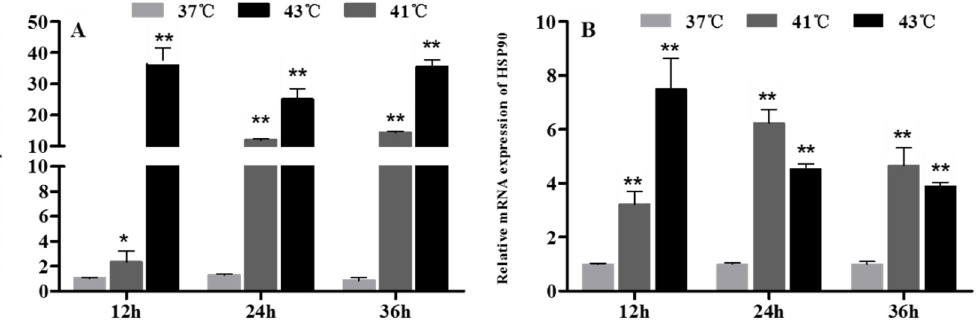
Figure 5. The effect of heat treatment on HSP70 ( A ) and HSP90 ( B ) mRNA expression levels in chicken granulosa cells. * p < 0.05, ** p < 0.01.